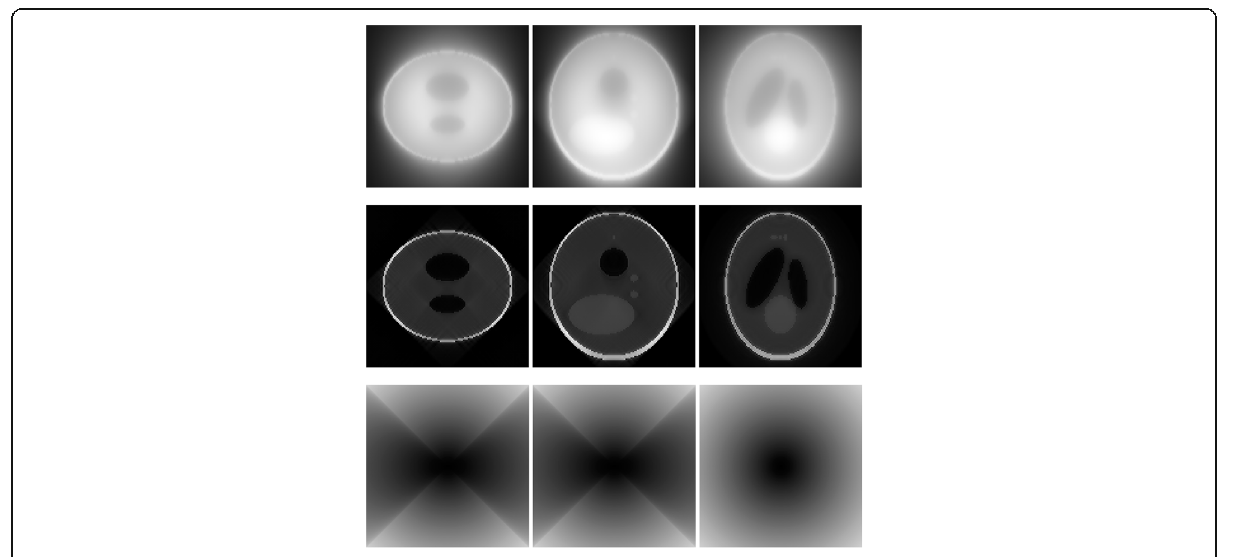
Fig. 8 Image reconstruction using proposed algorithm for the case of ψ = π /4 and σ = 100. Row 1 : TOF backprojection. Row 2 : Final reconstruction. Row 3 : Tomographic filter H . Three central orthogonal cuts are shown for each row